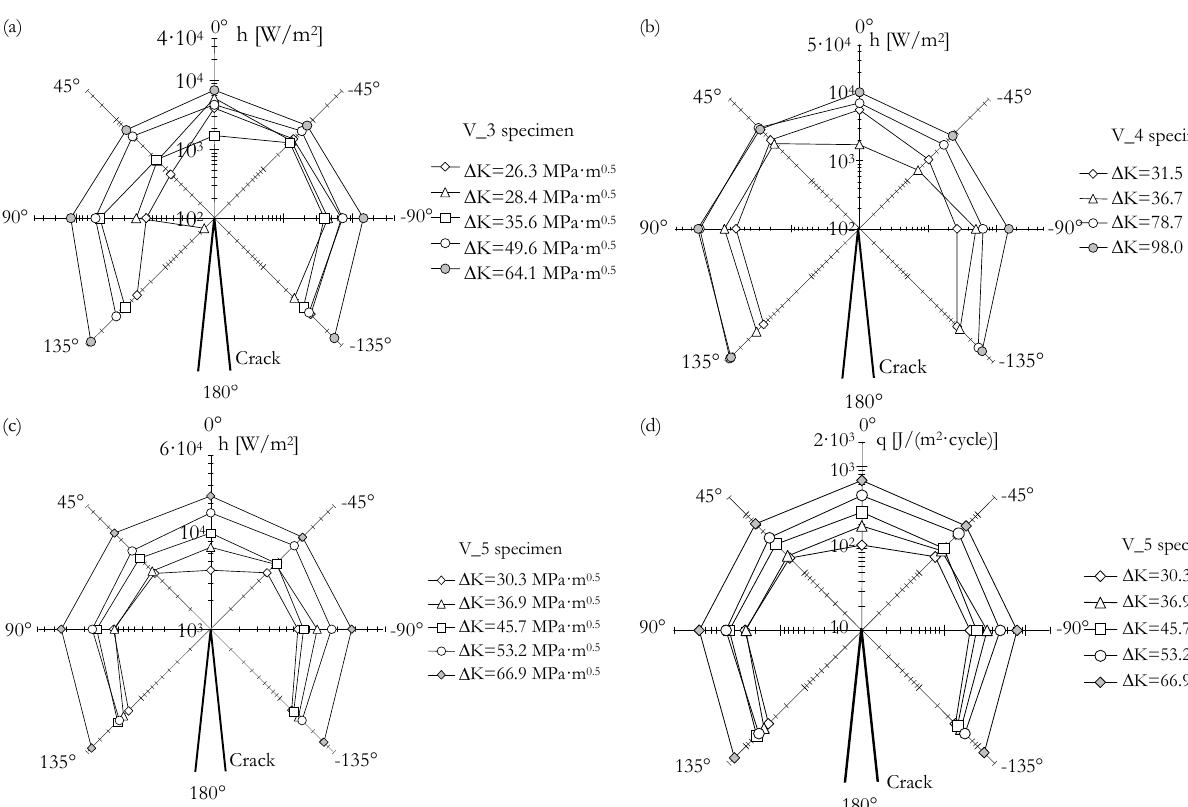
Figure 5: Distribution of the thermal flux h along the boundary of the control volume for different  angles for (a) V_3, (b) V_4 (c) V_5 specimen and (d) and corresponding energy flux per cycle q of V_5